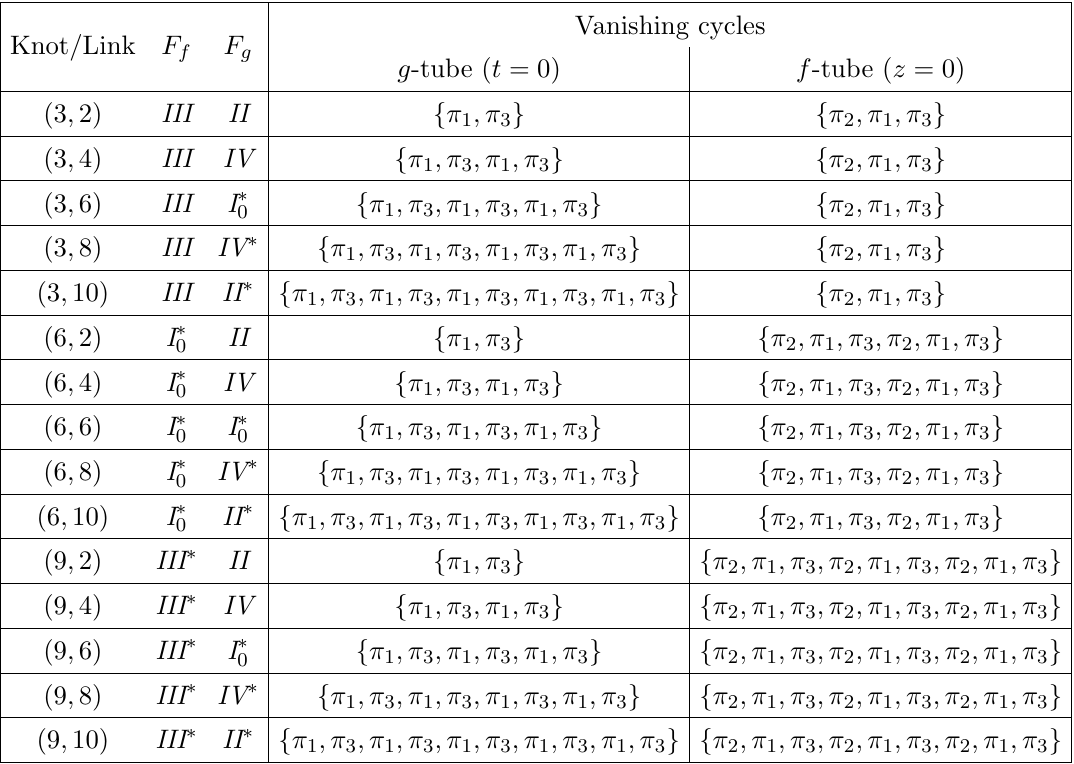
Table 3. Vanishing cycles for the various torus knots or